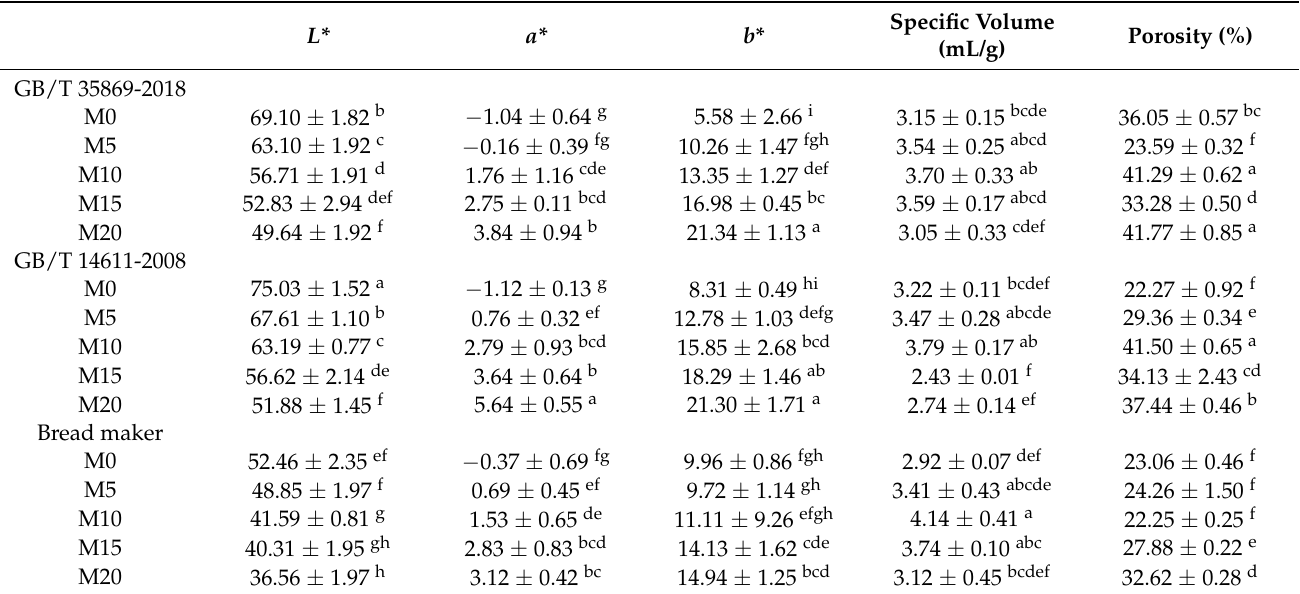
Table 5. The colorimetric properties, specific volumes, and porosity of bread with various mealworm powder substitution